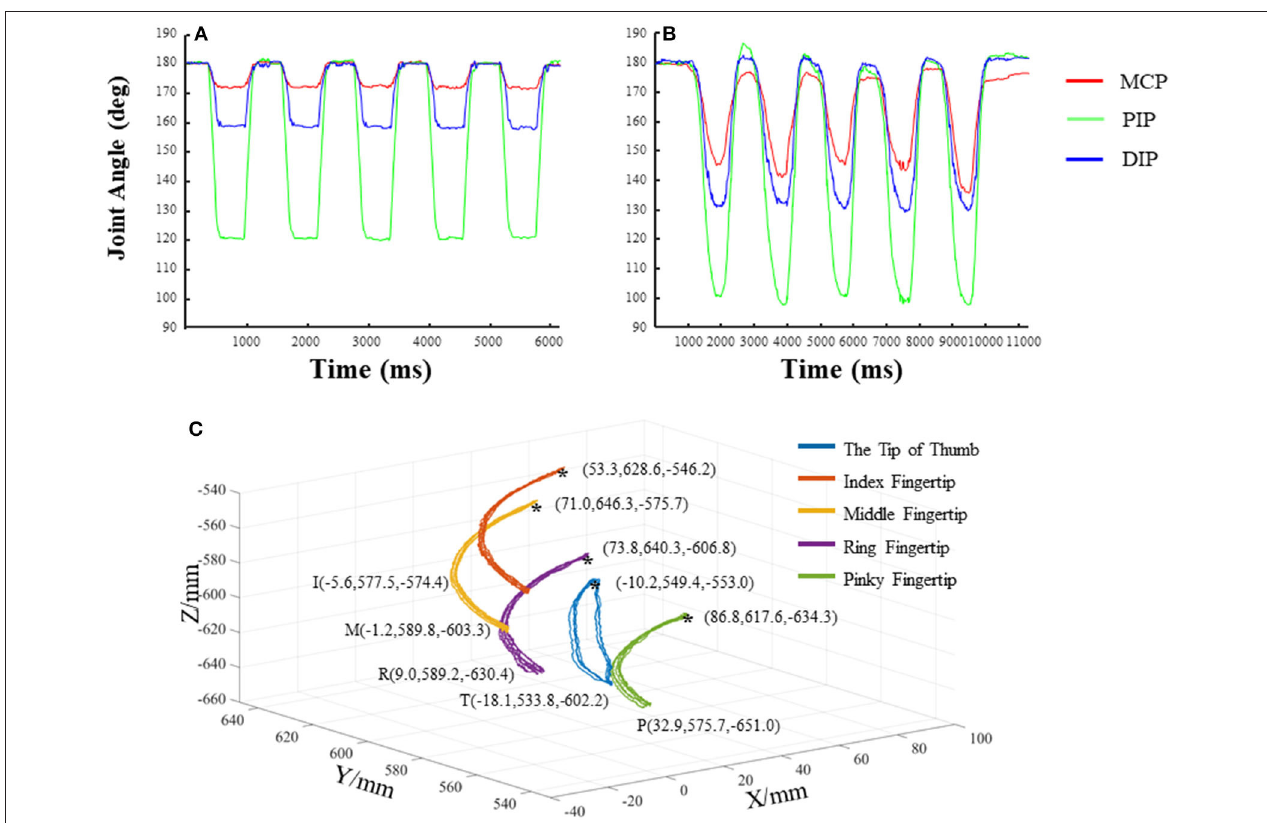
FIGURE 6 | The joint angles and trajectories of the exoskeleton and human digits during flexion and extension. (A) The joint angles of the metacarpophalangeal joint (MCP), PIP, and DIP of the exoskeleton index finger; (B) the joint angles of the MCP, PIP, and DIP of the index finger of a representative subject; (C) the trajectories of the exoskeleton